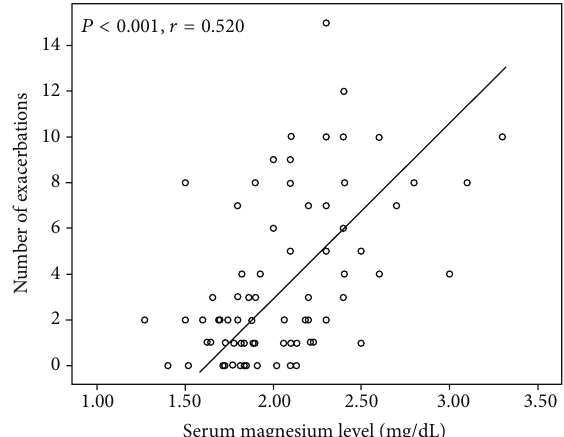
Figure 1: Scatterplot showing the positive correlation between number of exacerbations and serum magnesium level.